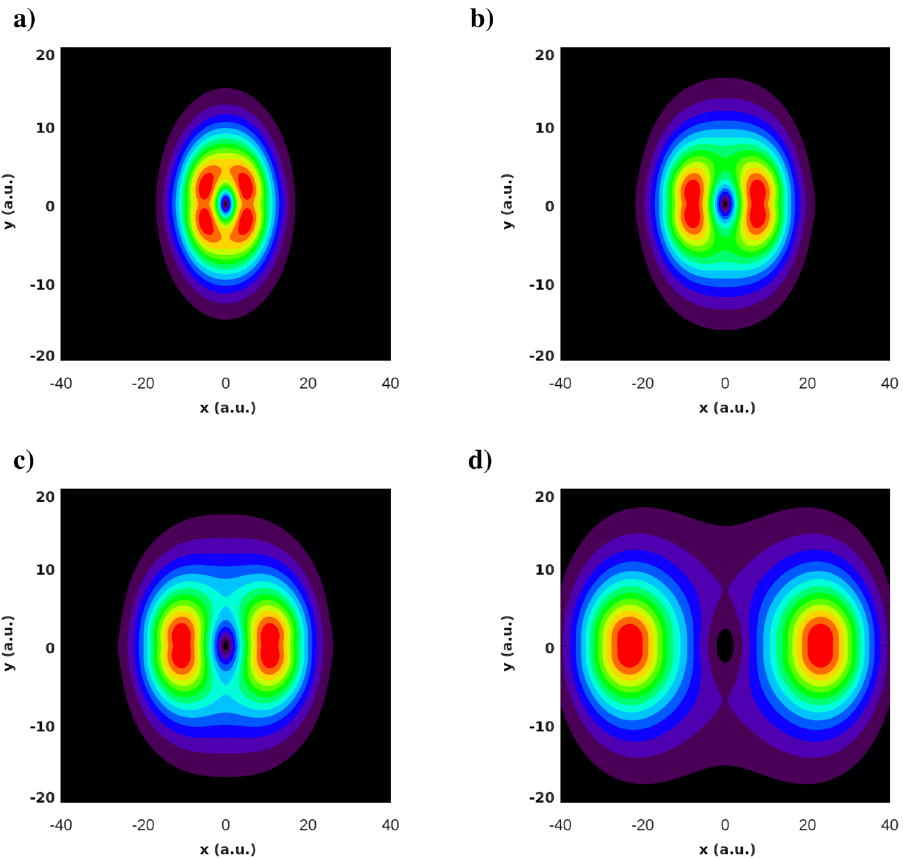
Figure 2. Coordinate density of the ground state wave-function for different values of the IR field strength: E 0 0.02387 a.u. ( a ), E 0 =